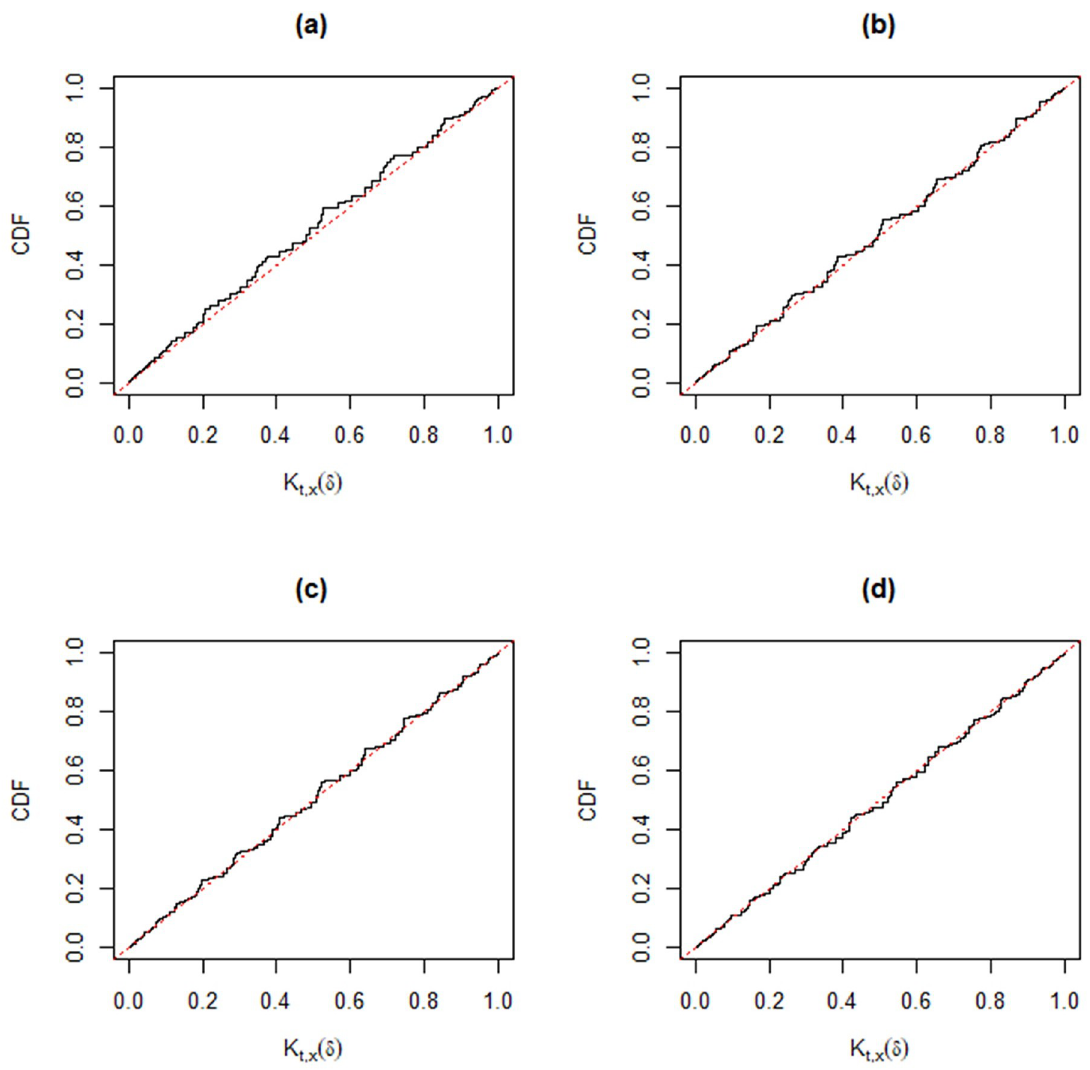
Fig 8. Distribution functions of K ( δ ) (black) compared with that of Unif(0, 1) (gray) based on Monte Carlo samples from the t , x trinomial distribution versus p 12 for fixed n = 50 and p 11 = 0.3. Panel (a): p 12 = 0.1. Panel (b): p 12 = 0.2. Panel (c): p 12 = 0.3. Panel (d): p 12 =